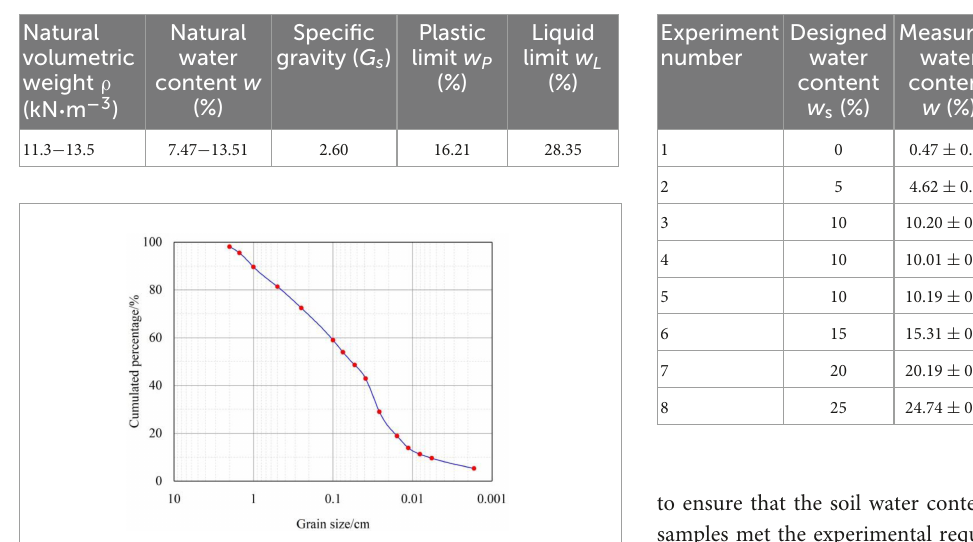
TABLE 2 The basic physical properties of loess.